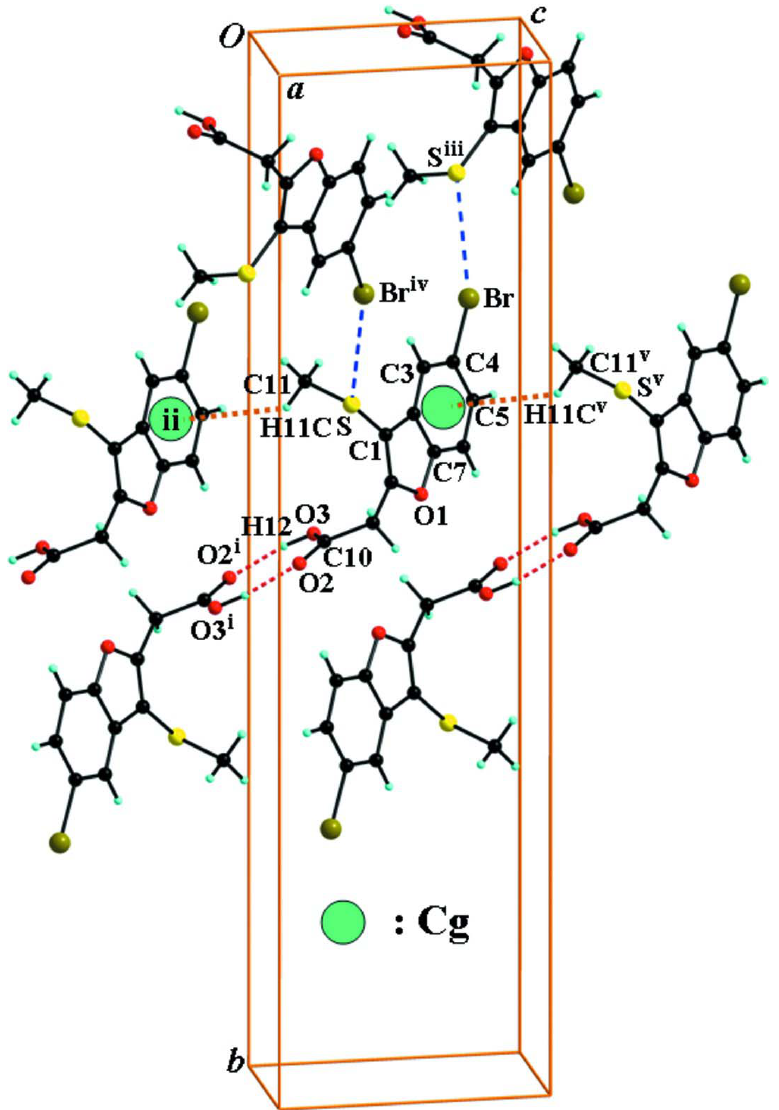
C—H··· π and Br···S interactions, and hydrogen bonds (dotted lines) in the title compound. Cg denotes the ring centroid. [Symmetry code: (i) -x+1, -y+1, -z; (ii) x, y+1, z-1; (iii) x-1, -y+1/2, z+1/2; (iv) x+1, -y+1/2, z-1/2; (v) x, y,